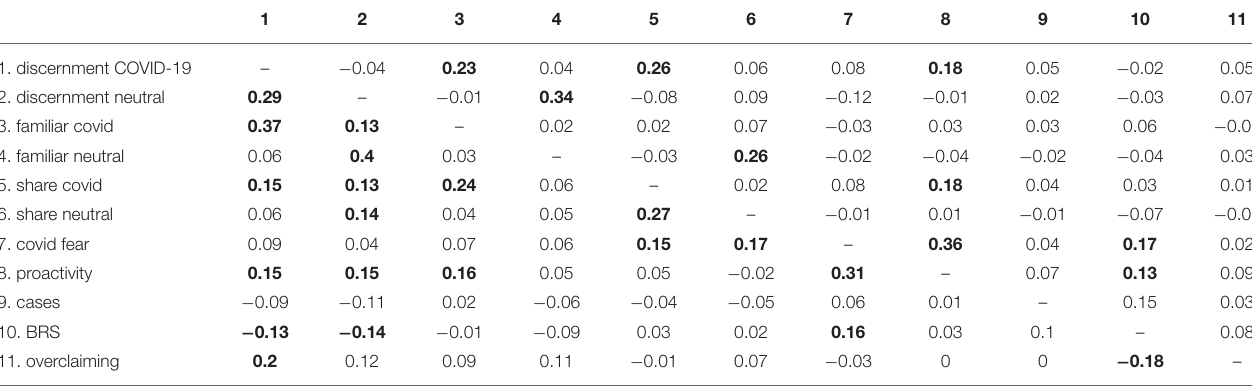
TABLE 1 | Absolute correlation coefficients (Pearson’s r ) for fake news and covid factors for the USA (lower diagonal) and ITA (upper diagonal) samples.